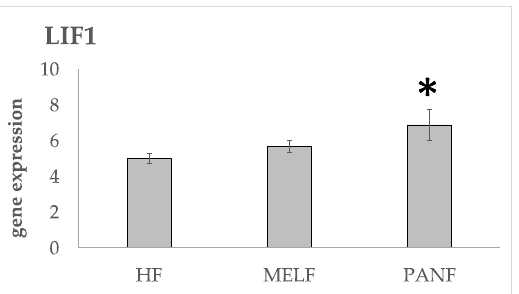
Figure 7. Comparison of the gene activity of LIF in normal fibroblasts and CAFs from the melanoma (MELF) and PDAC (PANF). A statistically significant difference between HFs and other cell lines at adjusted p -value < 0.05 is marked by an asterisk.